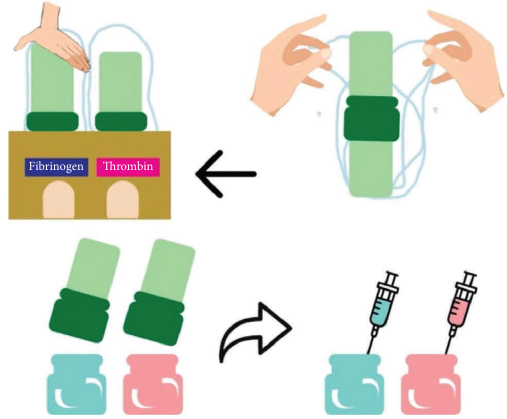
Figure 1: Beriplast solution preparation before injection